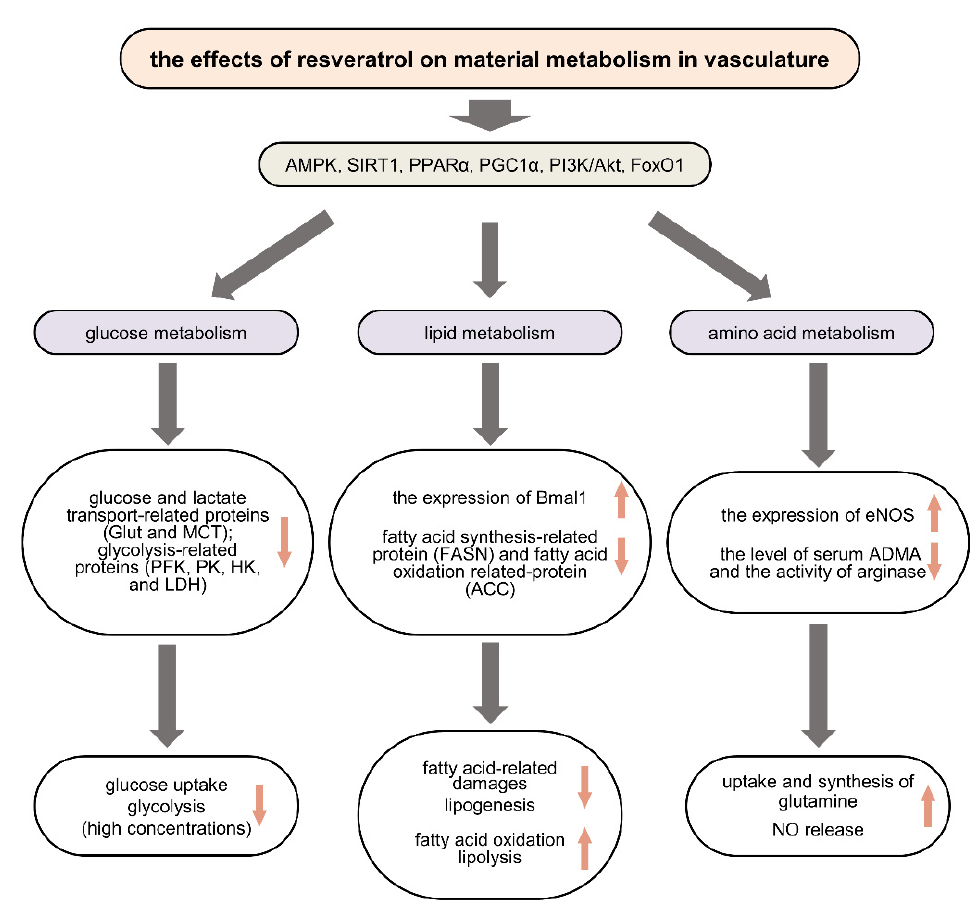
Figure 1. Resveratrol improves glucose, lipid, and amino acid metabolism in vascular cells by regulating different pathways and targets. Resveratrol reduces glucose uptake and glycolysis by inhibiting the expression of Glut, MCT, PFK, PK, HK, and LDH ( left ). Resveratrol improves fatty acid-related damages by upregulating the expression of Bmal1, decreases lipogenesis by suppressing the expression of FASN, and activates fatty acid oxidation by suppressing the expression of ACC ( middle ). Resveratrol increases the uptake and synthesis of glutamine. It also upregulates NO release by elevating the expression of eNOS, suppressing the level of serum ADMA, and inhibiting the activity of arginase ( right ). AMPK: AMP-activated protein kinase; SIRT1: silent information regulator 1; PPAR α : peroxisome proliferator-activated receptor-gamma coactivator-1 α ; PGC1 α : peroxisome proliferator-activated receptor-gamma coactivator-1 α ; PI3K: Phosphoinositide 3-kinase; FoxO1: forkhead box protein O1; Glut: glucose transporter; MCT: monocarboxylate transporter; PFK: 6-phosphofructo-1-kinase; PK: pyruvate kinase; HK: hexokinase; LDH: lactate dehydrogenase; Bmal1: brain and muscle arnt-like protein-1; FASN: fatty acid synthase; ACC: acetyl-CoA carboxylase; NOS: nitric oxide synthase; ADMA: Asymmetric dimethylarginine.